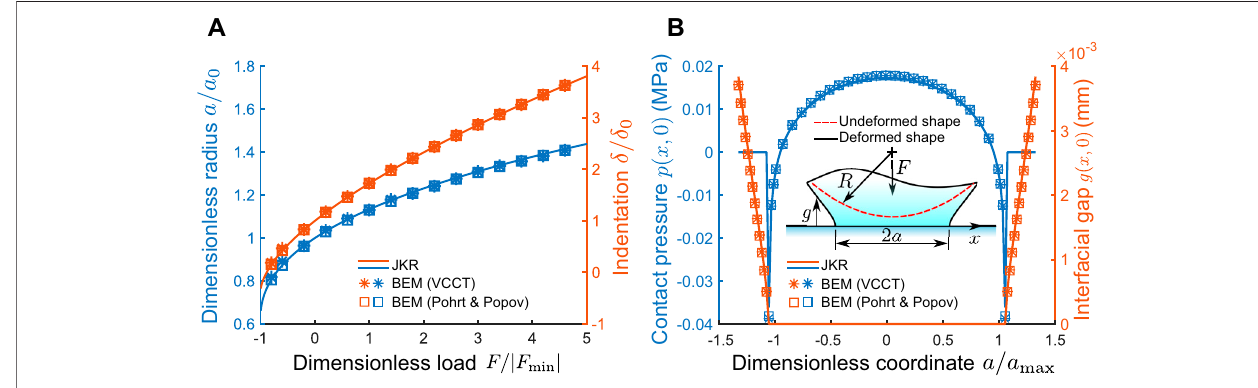
FIGURE 6 | (A) Dimensionless contact radius a ( F )/ a 0 and dimensionless indentation δ ( F )/ δ 0 ; (B) Contact pressure p ( x , 0) and interfacial gap g ( x , 0) at F (cid:1) 5| F min | where the contact radius is a